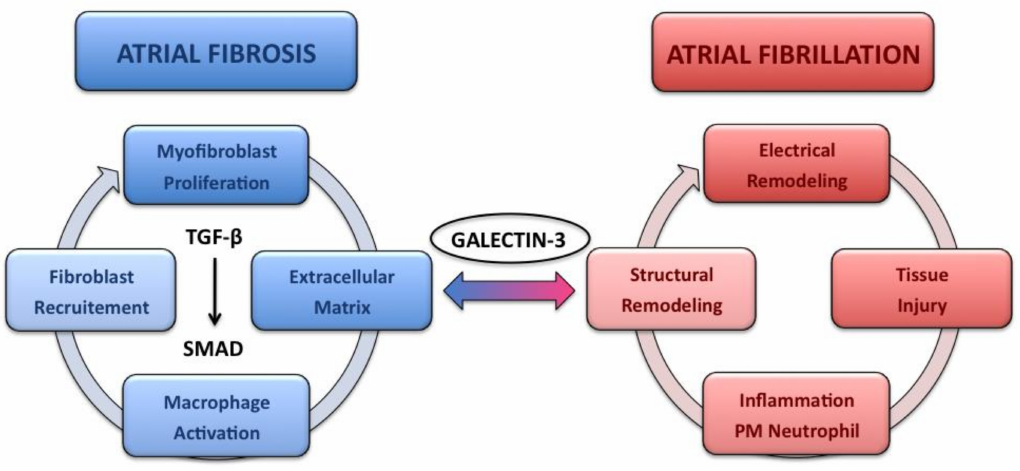
Figure 3. “Atrial fibrillation begets atrial fibrillation”. Galectin-3 production, promoted by atrial remodeling in atrial fibrillation patients, induces extracellular matrix production, mainly through the TGF- β /SMAD signaling pathway. Atrial fibrosis in return is associated with atrial dilatation, tissue anisotropy with heterogeneous electrical properties, which in turn favor atrial fibrillation initiation and